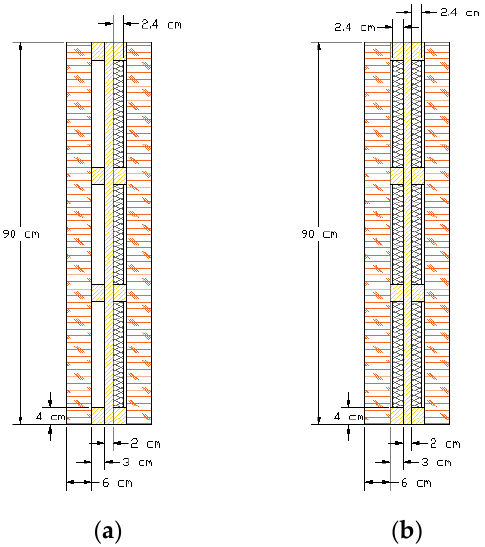
Figure 5. Configuration of the SuberWall panel with a single PCM layer in the air gap on the inner side ( a ) and with two PCM layers ( b ).